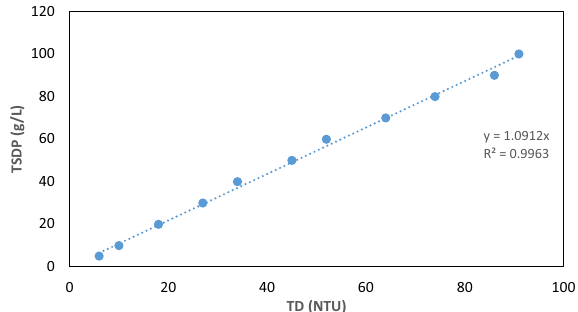
Figure 3. Total dissolved and suspended solids (TDSP) plots for aquaculture effluent